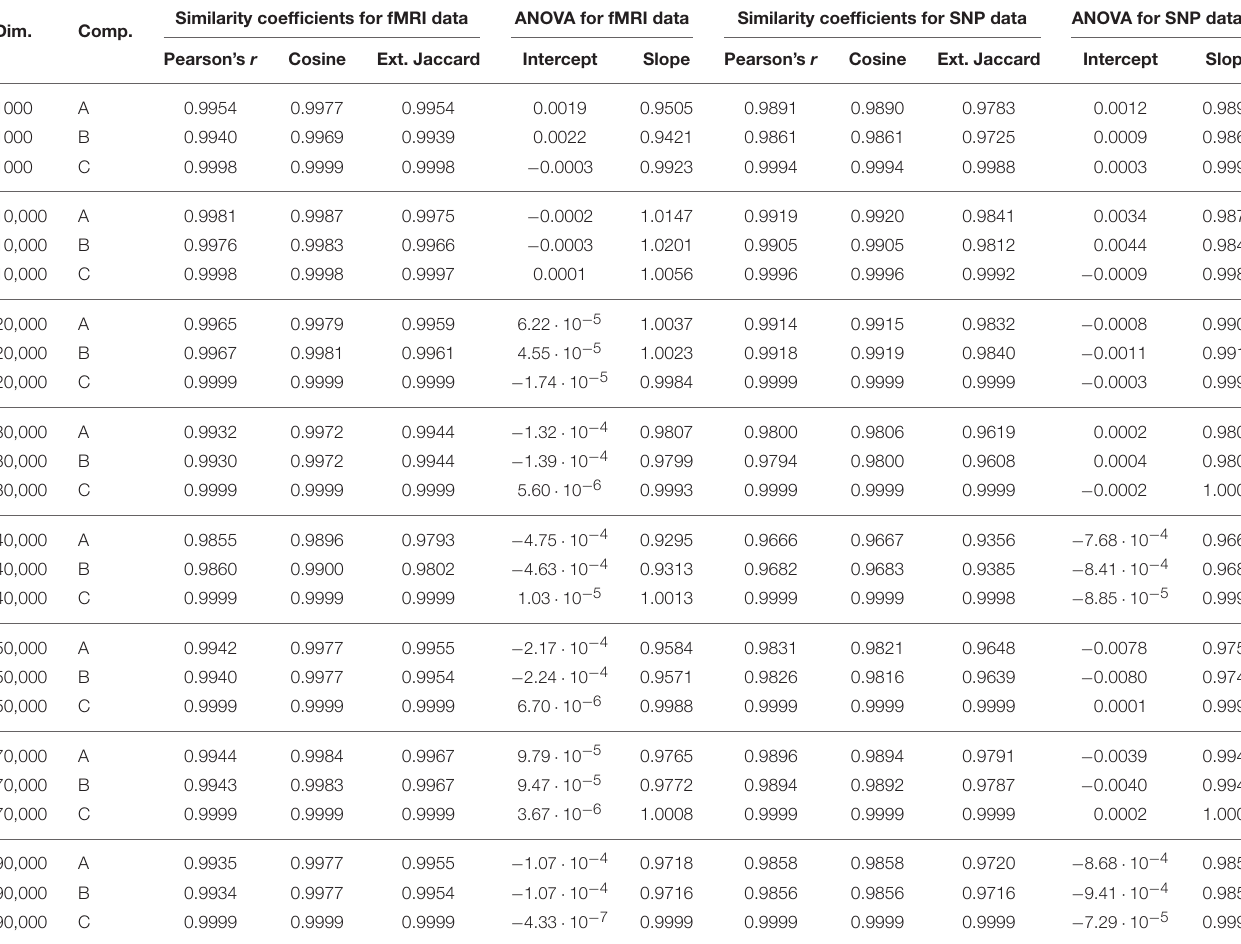
TABLE 5 | Similarity of weights of traditional PLSC and of PLSC-RP using random matrices with and without Gram–Schmidt orthogonalization.